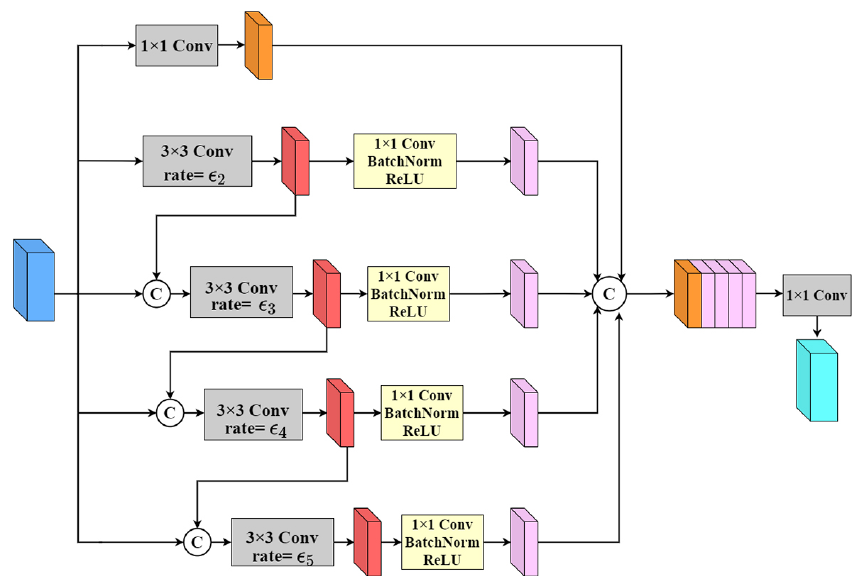
Figure 4. Multi-scale feature-fusion module based on dilated convolutions with different dila- tion